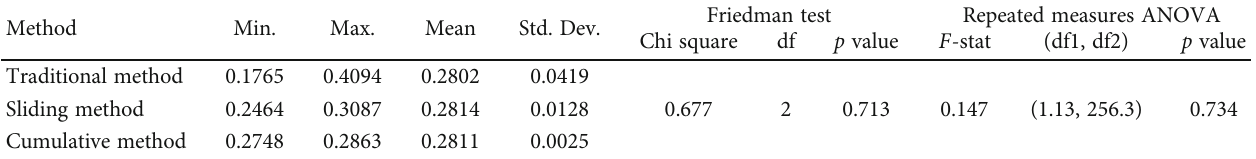
Table 2: Friedman and ANOVA tests for the comparison of volatilities for the three methods.